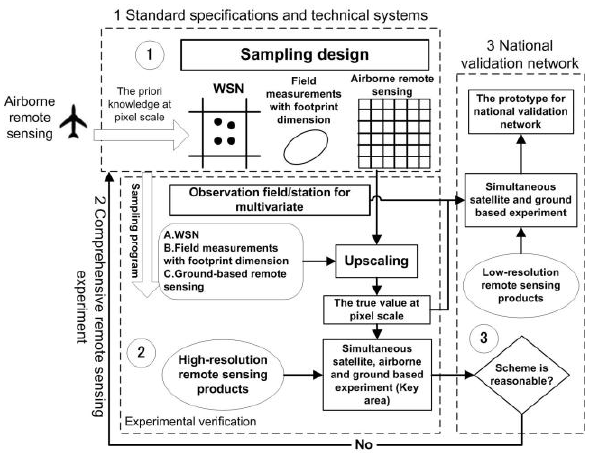
Figure. 1 The general flowchart of the validation